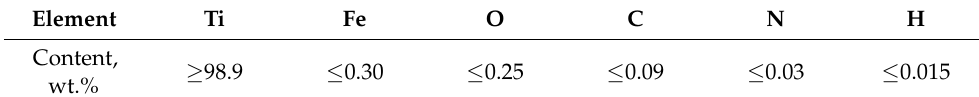
Table 1. Nominal chemical composition of Grade 2 CP titanium.